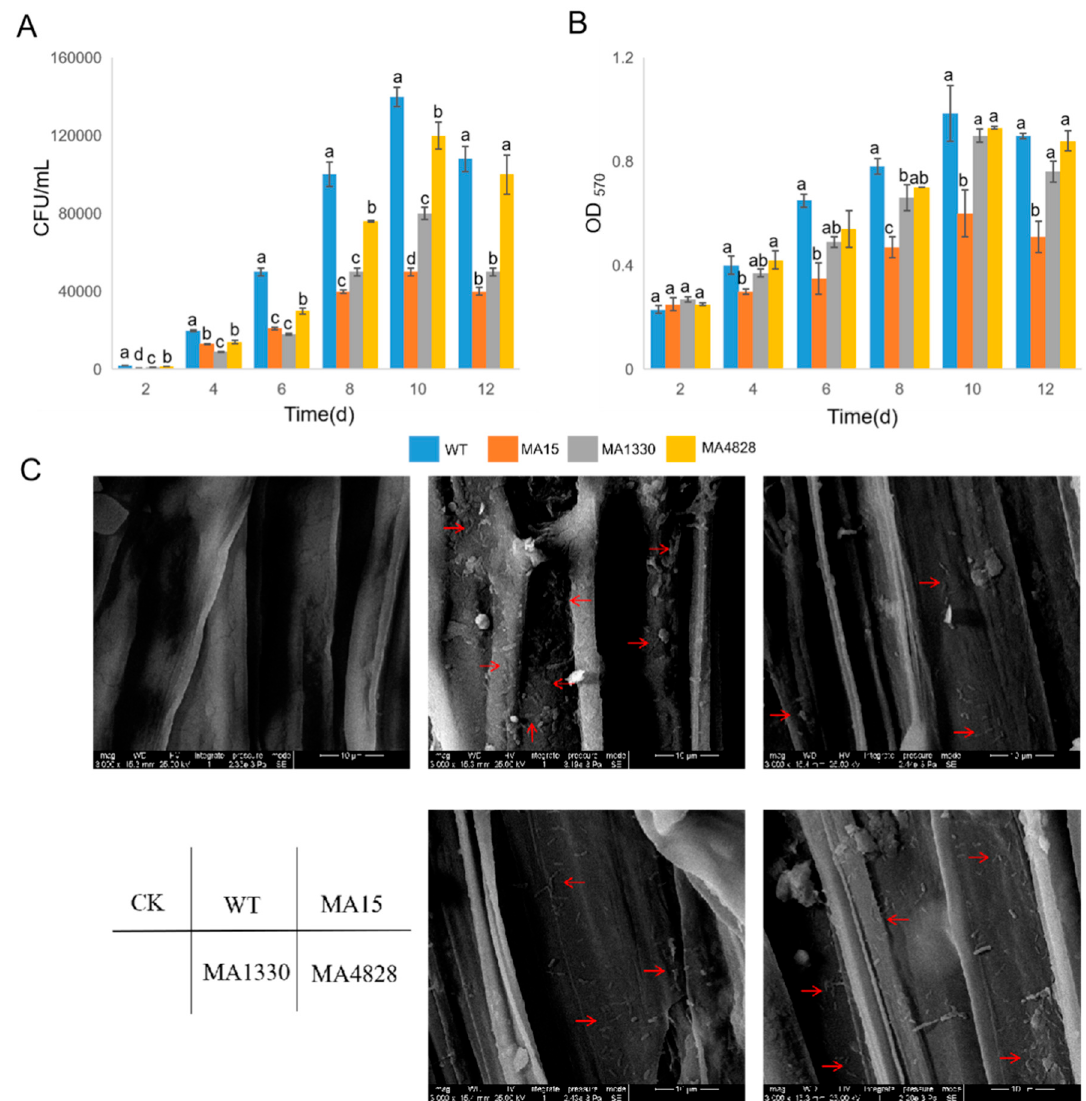
Figure 4. The colonization of B. pumilus HR10 WT and mutants on the roots of P. massoniana seedlings. ( A ) The population of cells attached to the root. ( B ) The quantitative absorbance of crystal violet staining assay of the root. ( C ) SEM micrographs of colonized seedling roots. Different letters above the bars indicate significant differences ( p < 0.05).